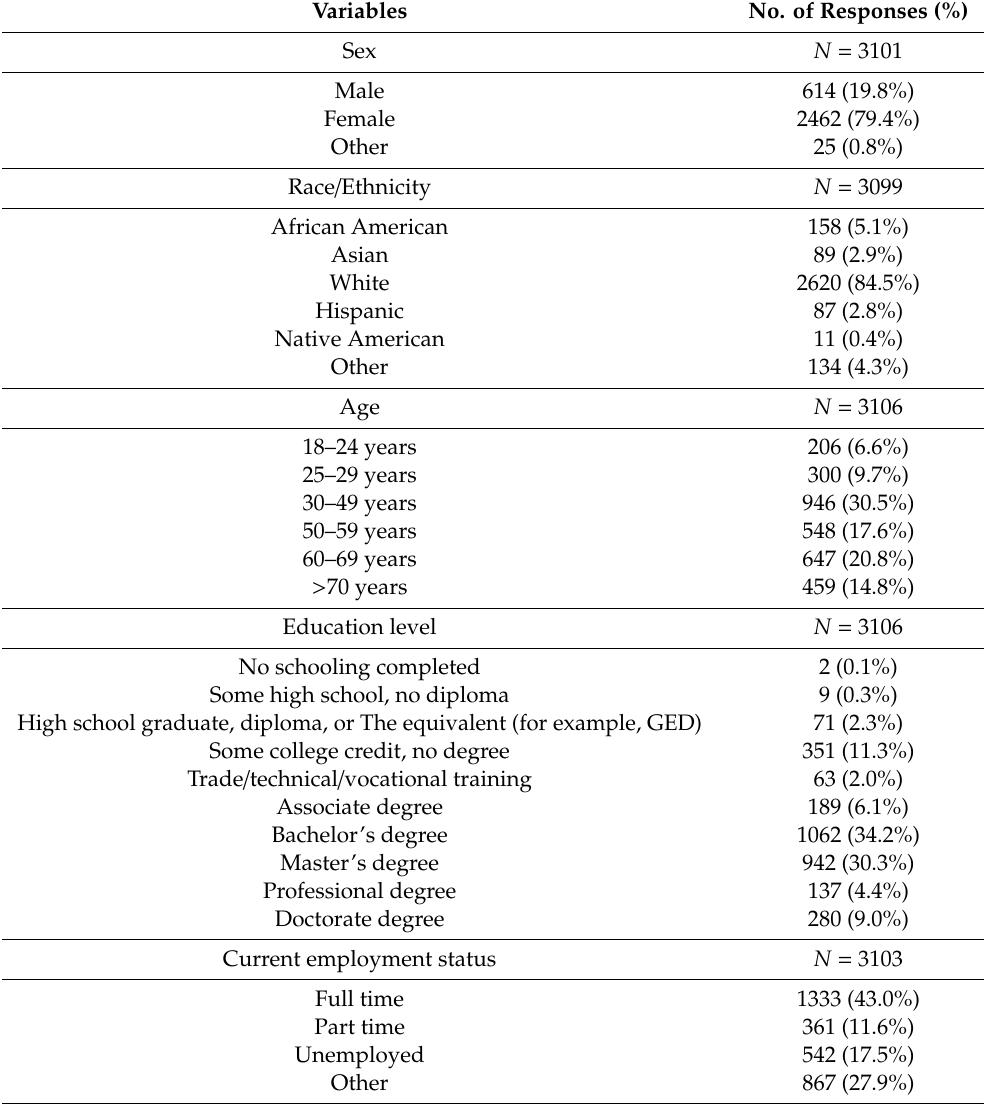
Table 2. Participants’